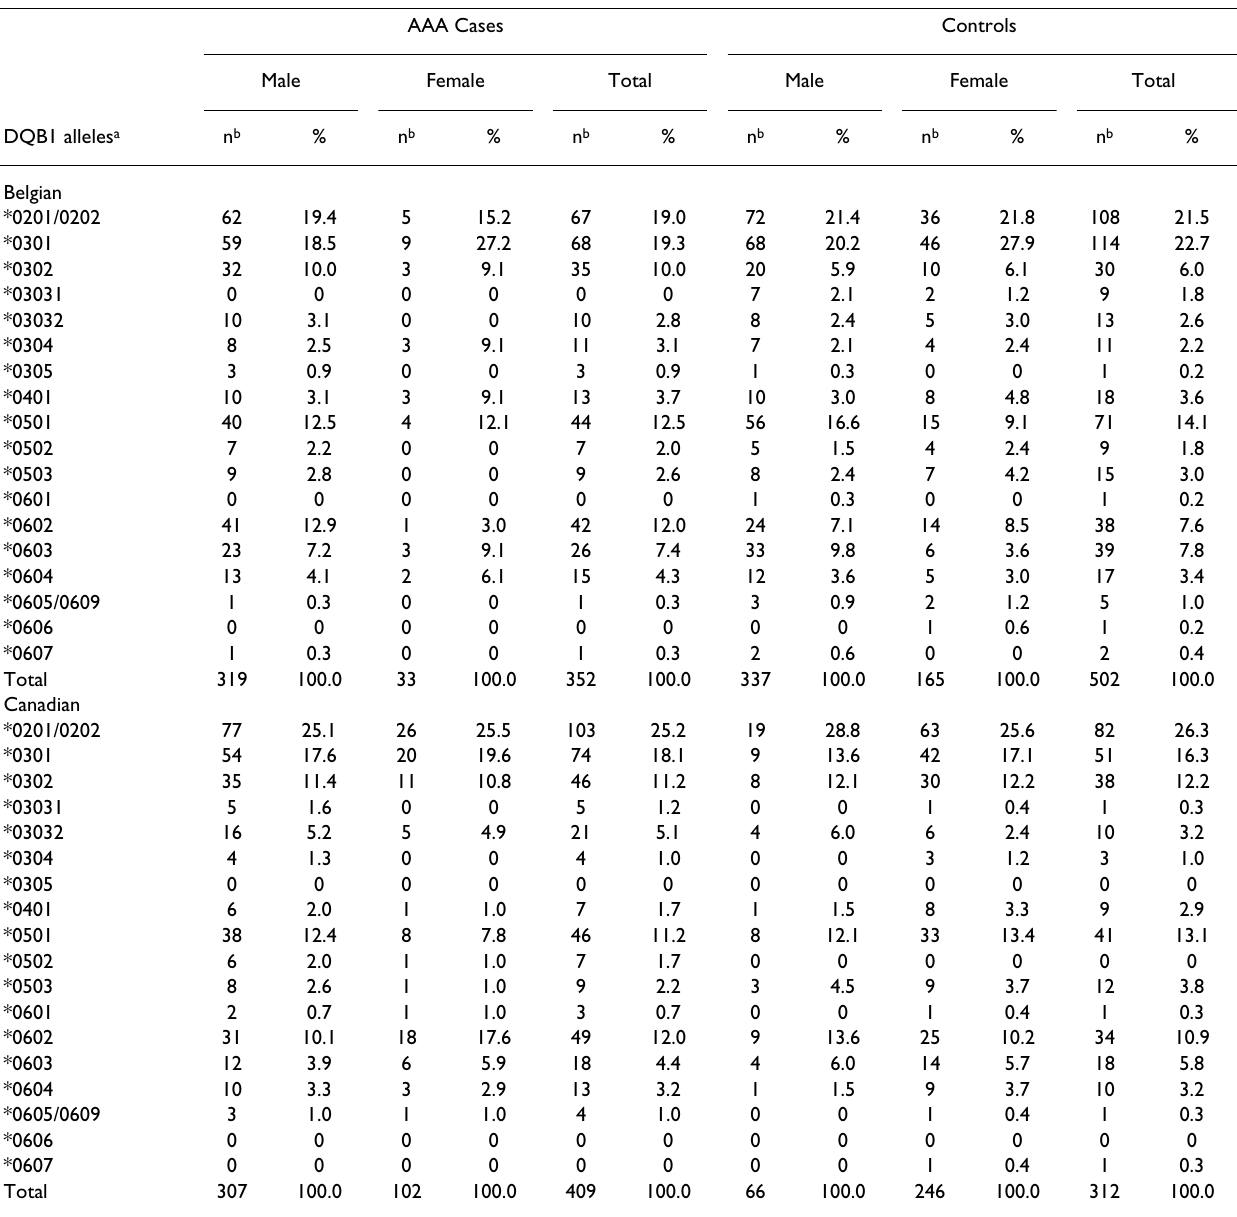
Table 2: HLA-DQB1 allele frequencies in AAA cases and